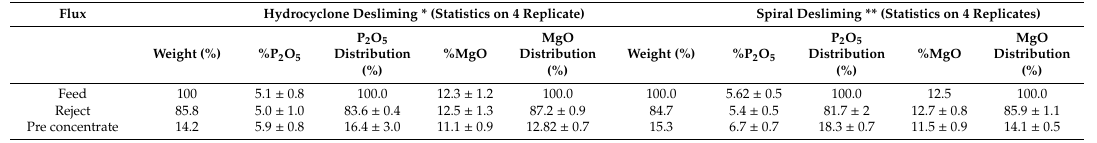
Table 5. Results of the pre-concentration using the hydrocyclone and the spiral concentrator (P 2 O 5 and MgO contents and distributions are average values of 4 repetitions ± the standard deviation).